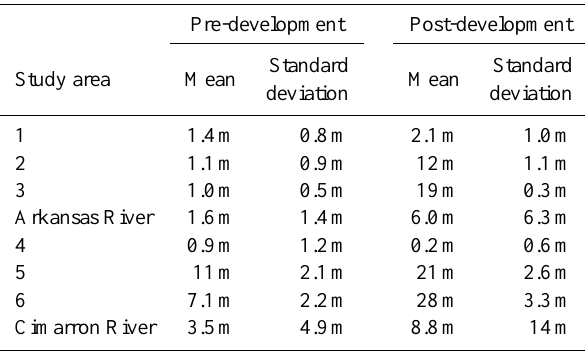
Table 1. The aggregate canopy area covered by phreatophytes along the Arkansas and Cimarron River corridors.